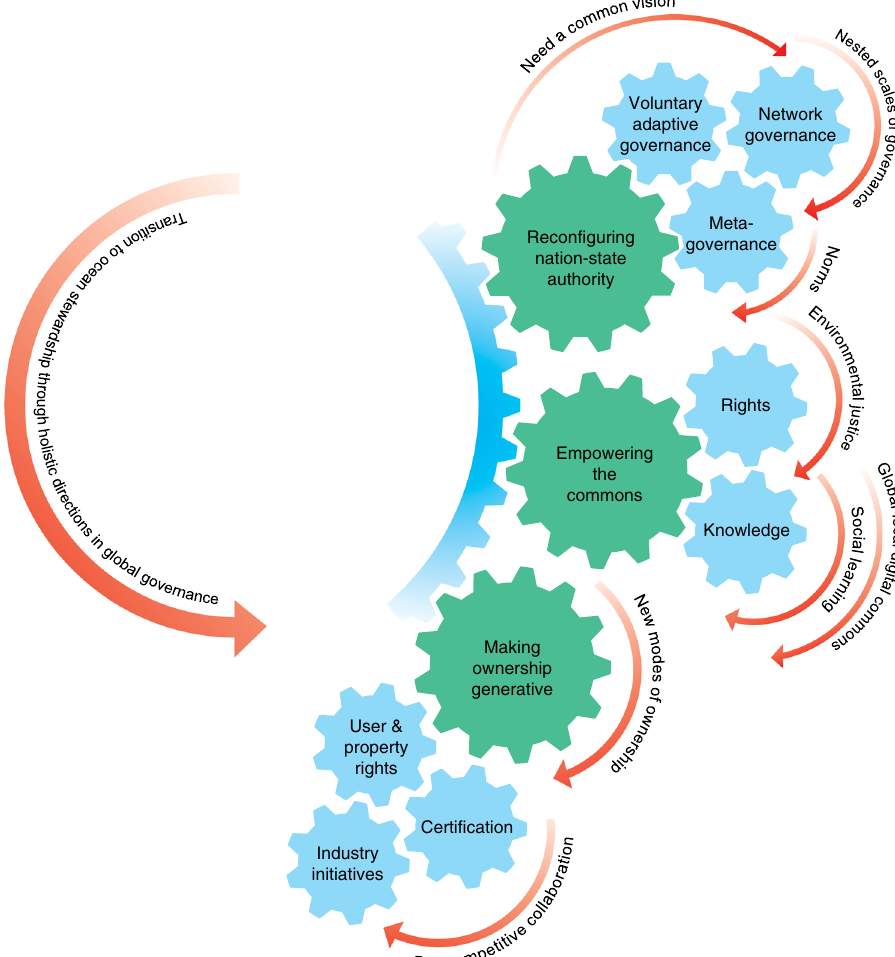
Fig. 2 Elements of a governance transition to ocean stewardship. Elements informing a transition to a more adaptive and responsive global ocean governance system for ocean stewardship driven by three primary levers: recon fi guring nation state governance; empowering the commons through justice, equity and knowledge; and making ownership generative by integrating rights with responsibilities. Concepts based on Bollier 12